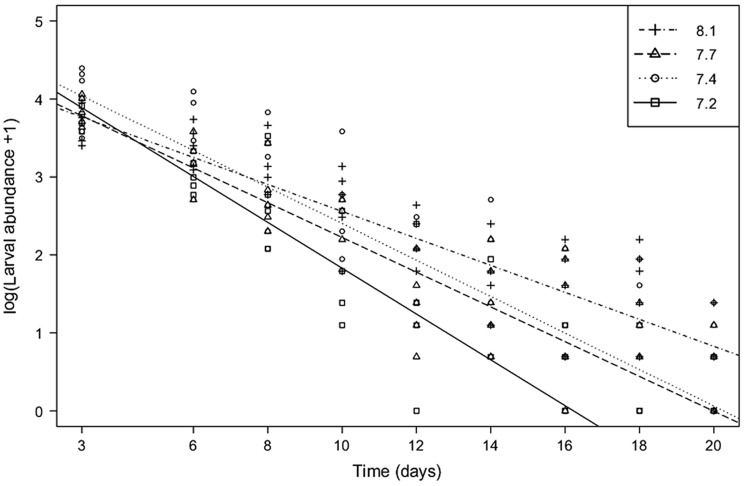
Larval abundance in different pH treatments over time.The relationship between logarithmic larval abundance and time for four different pH treatments. Lines were plotted using coefficients from the GLMM. The first two sampling points were on days 3 and 6, after which the larval sampling was conducted every other day. Each replicate (n = 20) for each sampling point is shown.